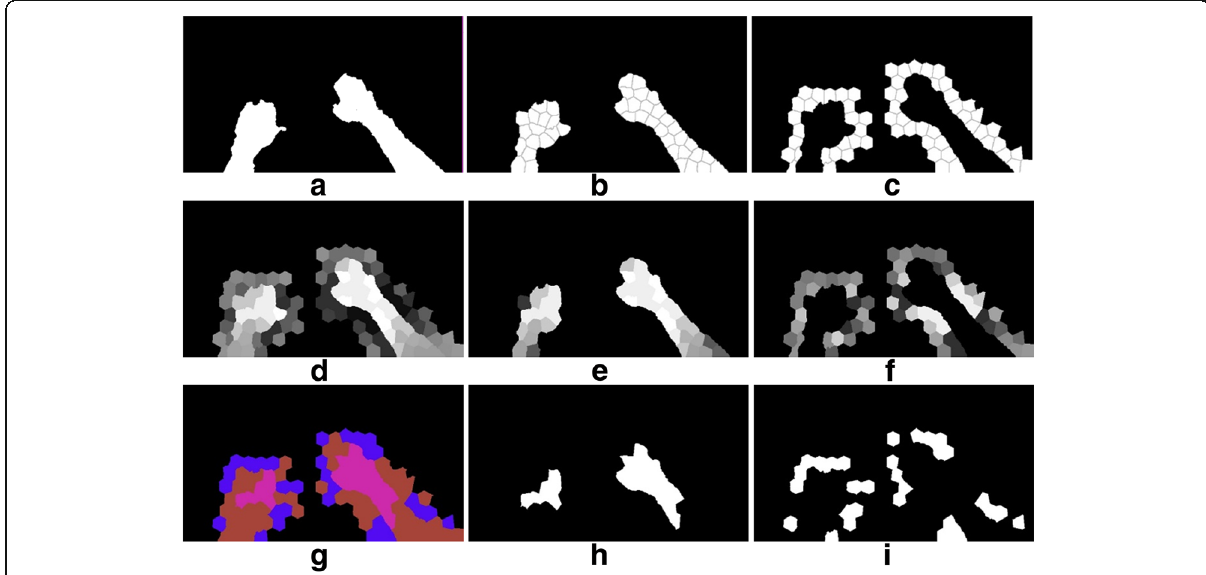
Fig. 5 Select superpixel samples based on energy optimization. a – i show the process of selection. Blue, pink, and brick in ( g ) illustrate the selected background, foreground, and abandoned samples